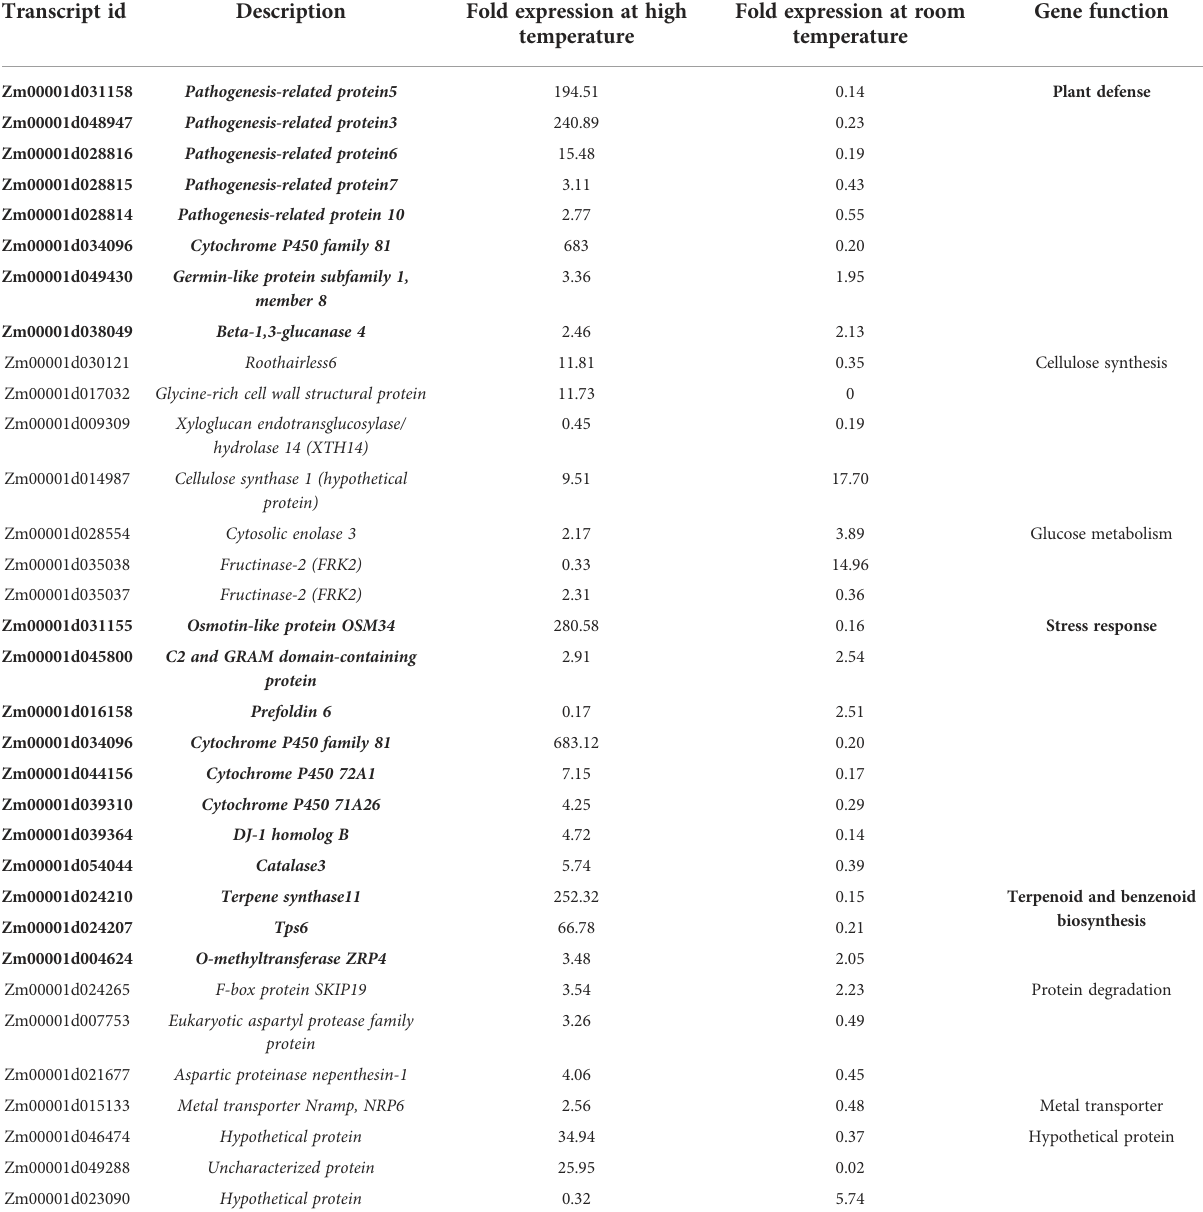
TABLE 5 The common DEGs after guvermectin treatment at high temperature and room